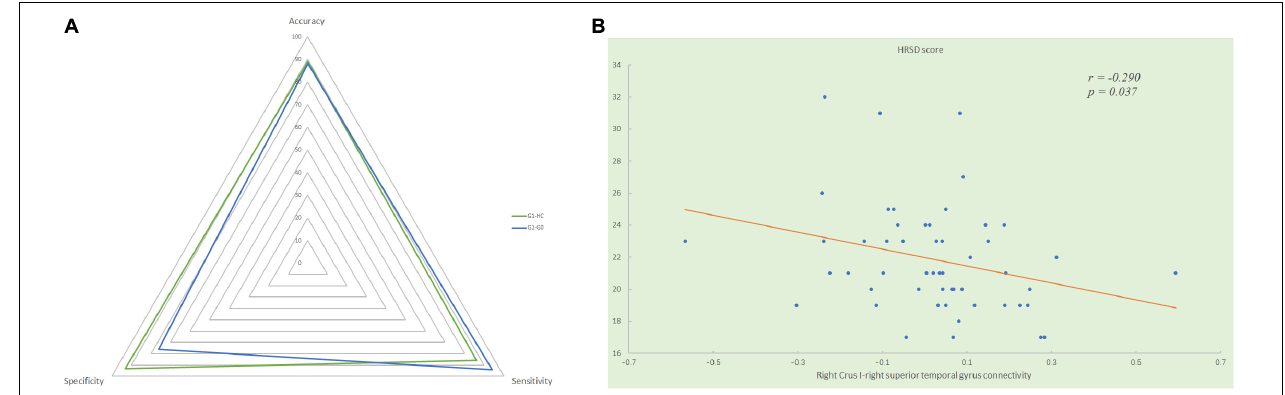
FIGURE 3 | (A) Significantly negative correlation between the HRSD scores and the mean functional connectivity values of the right Crus I - right superior temporal gyrus connectivity in all patients with MDD. (B) The radar graph shows the accuracy, sensitivity, specificity of the classifications of group G1 versus G0 and group G1 versus HC. HRSD, Hamilton Rating Scale for Depression; G1, MDD patients with gastrointestinal symptoms; G0, MDD patients without gastrointestinal symptoms; HC, healthy